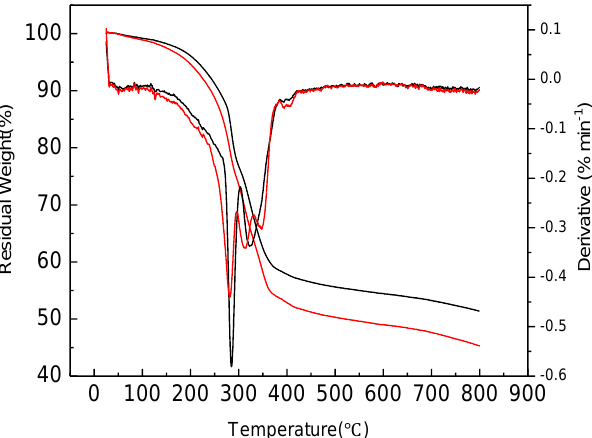
Figure 4. TG-DTG curves of Et- N -Cu(BDC-NH 2 )(DMF)(red) and Cu(BDC-NH 2 )(DMF)(black).